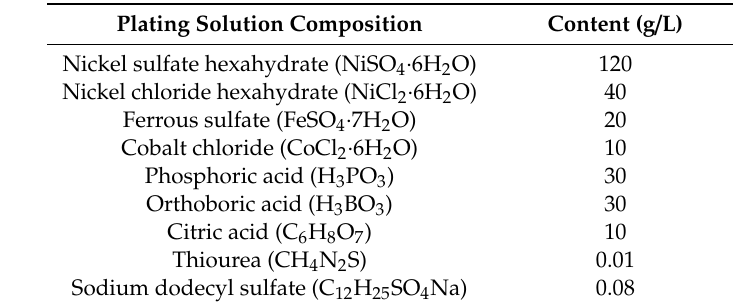
Table 2. Composition of plating solution.